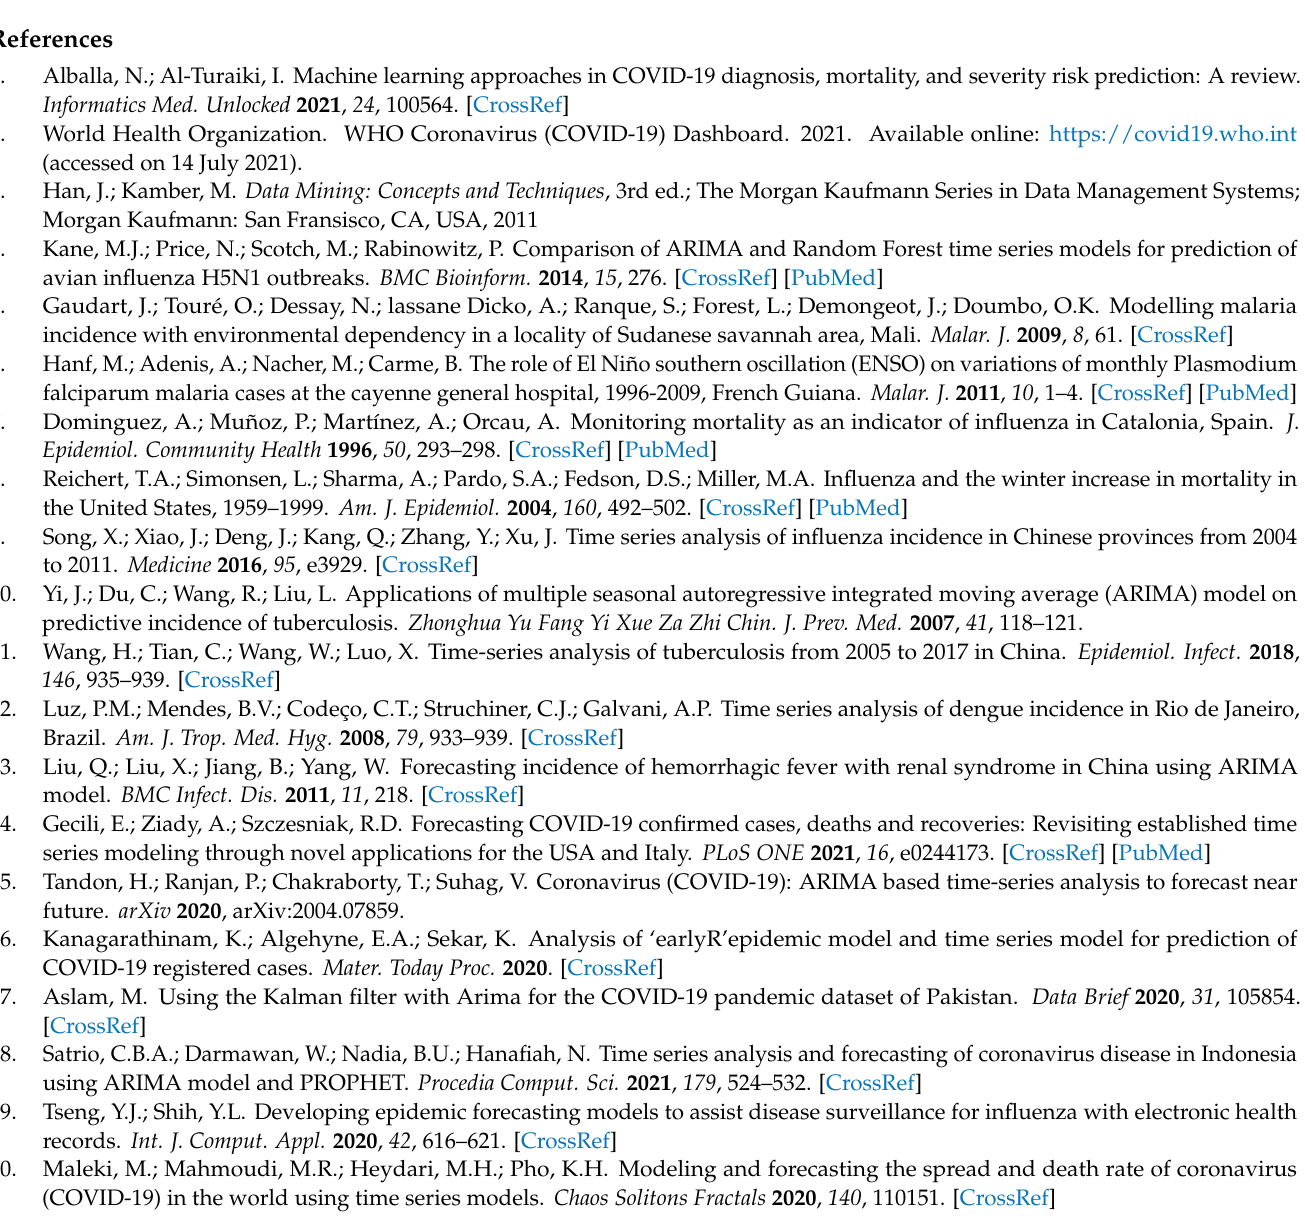
Table S3: KSA forecasted recoveries, Table S4: KSA forecasted deaths, Table S5: Riyadh forecasted confirmed cases, and Table S6: Riyadh actual